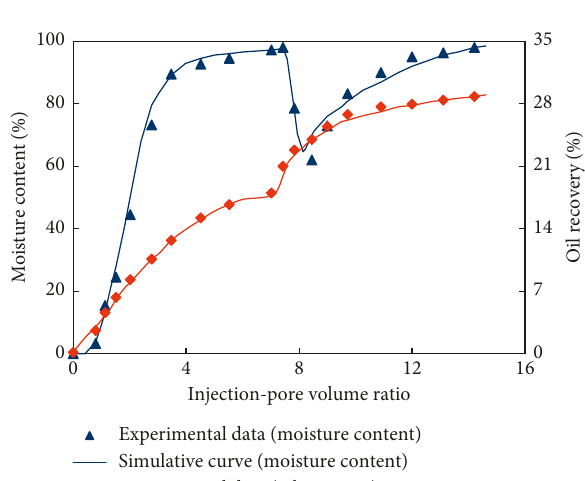
improved by 10.8 percentage points; the relative errors of main development indexes are within 4%.